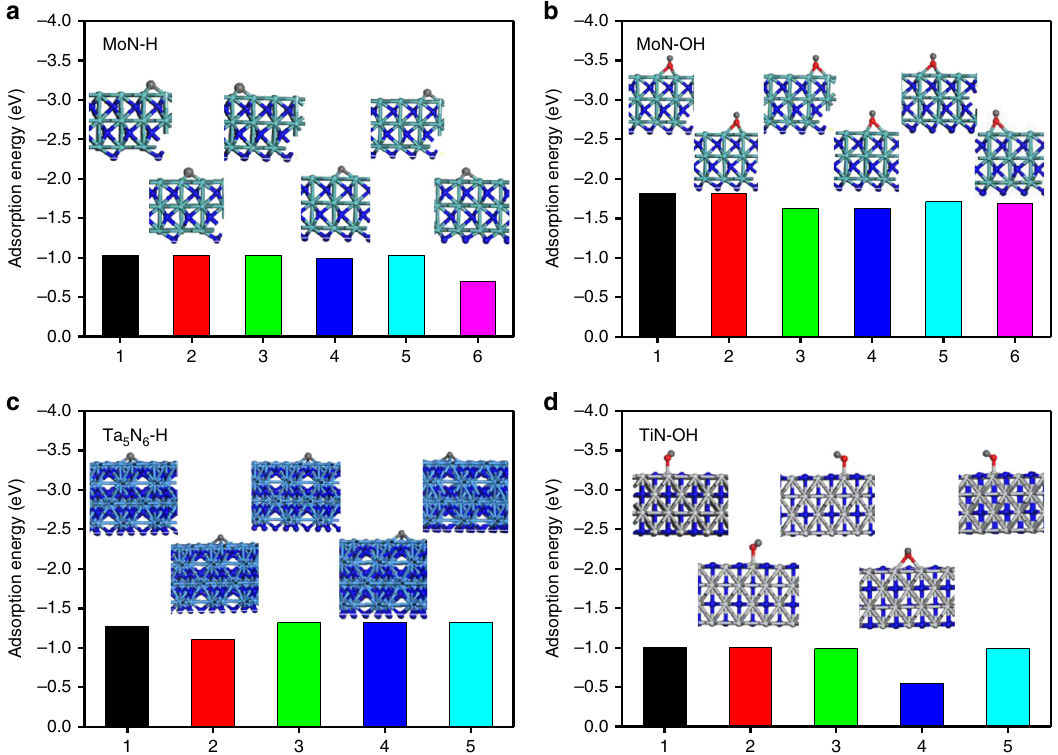
Fig. 4 The calculated adsorption energy of species on crystal surface. The a H + and b OH − adsorption on MoN surface. c The H + adsorption on Ta 5 N 6 surface. d The OH − adsorption on TiN surface. Inset images are the corresponding adsorption con fi